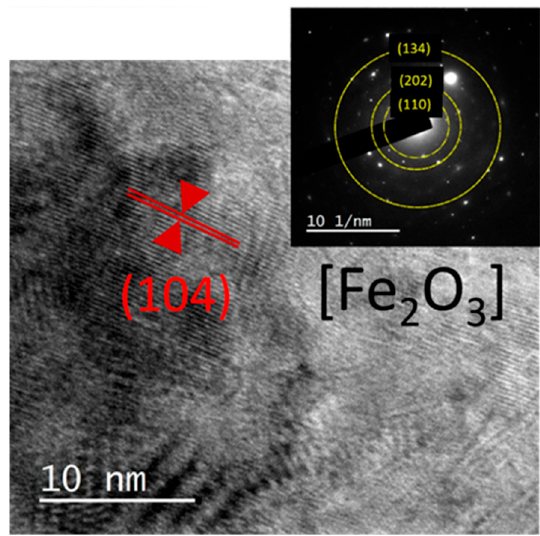
Figure 3. Micrographs of V1-8M-7D with HRTEM showing lattice fringes corresponding to hematite, with the corresponding selected area electron diffraction (SAED) pattern in the inset micrograph. Minerals 2020 , 10 ,